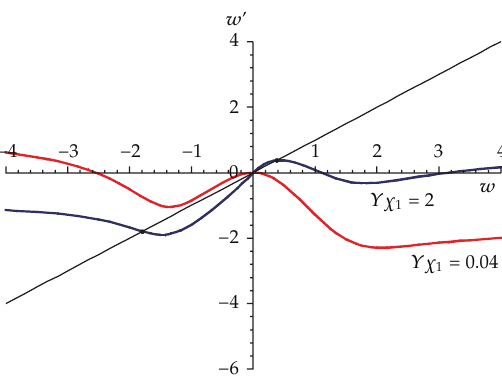
Figure 9: Pitchfork bifurcation: when Yχ 1 > 1 (cid:3) 0, 0 (cid:6) becomes unstable and two new fixed points